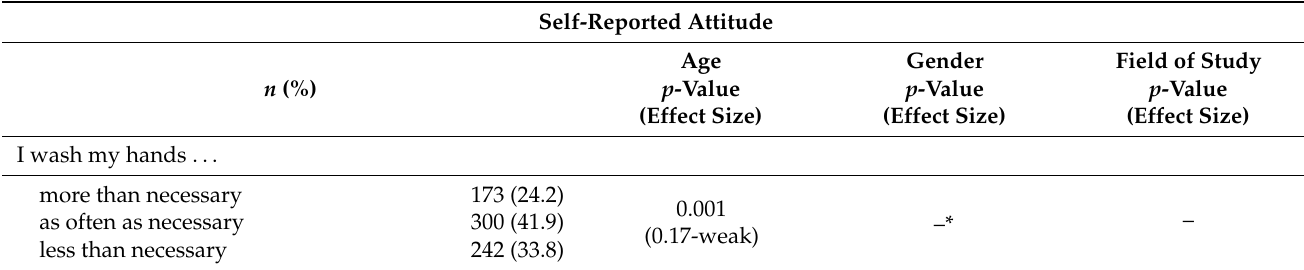
Table 5. Attitudes self-reported by the participants in relation to hand